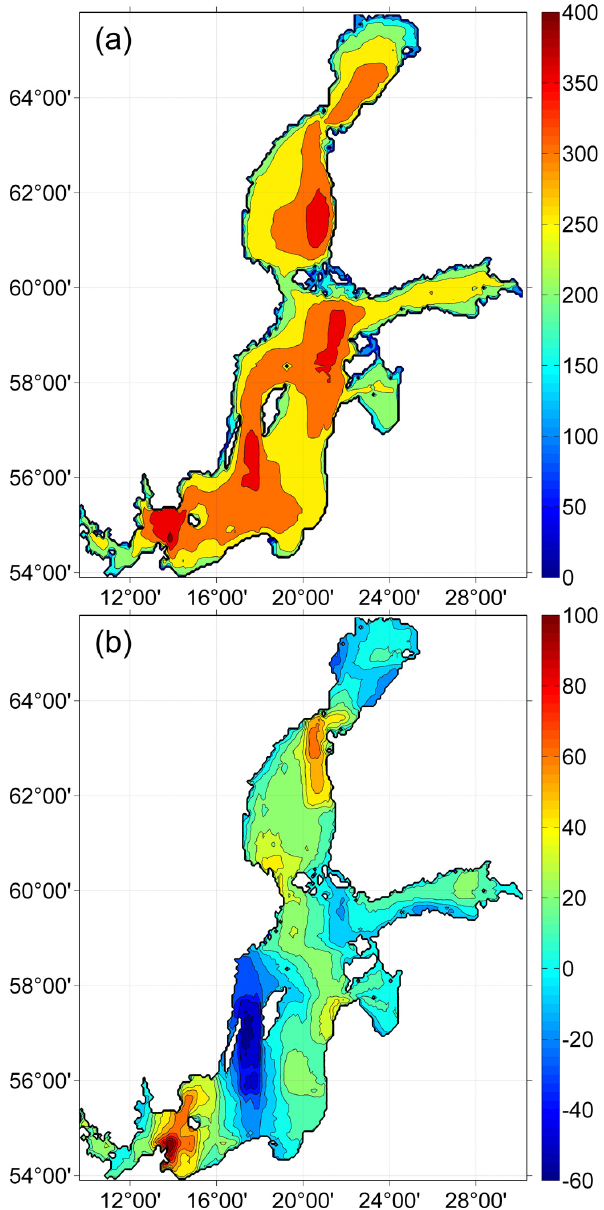
Fig. 6. (a) Numerically simulated 99th percentile of significant wave height (cm; isolines plotted after each 50cm) and (b) its change according to the linear trend in the Baltic Sea in 1970–2007 (cm; isolines plotted after each